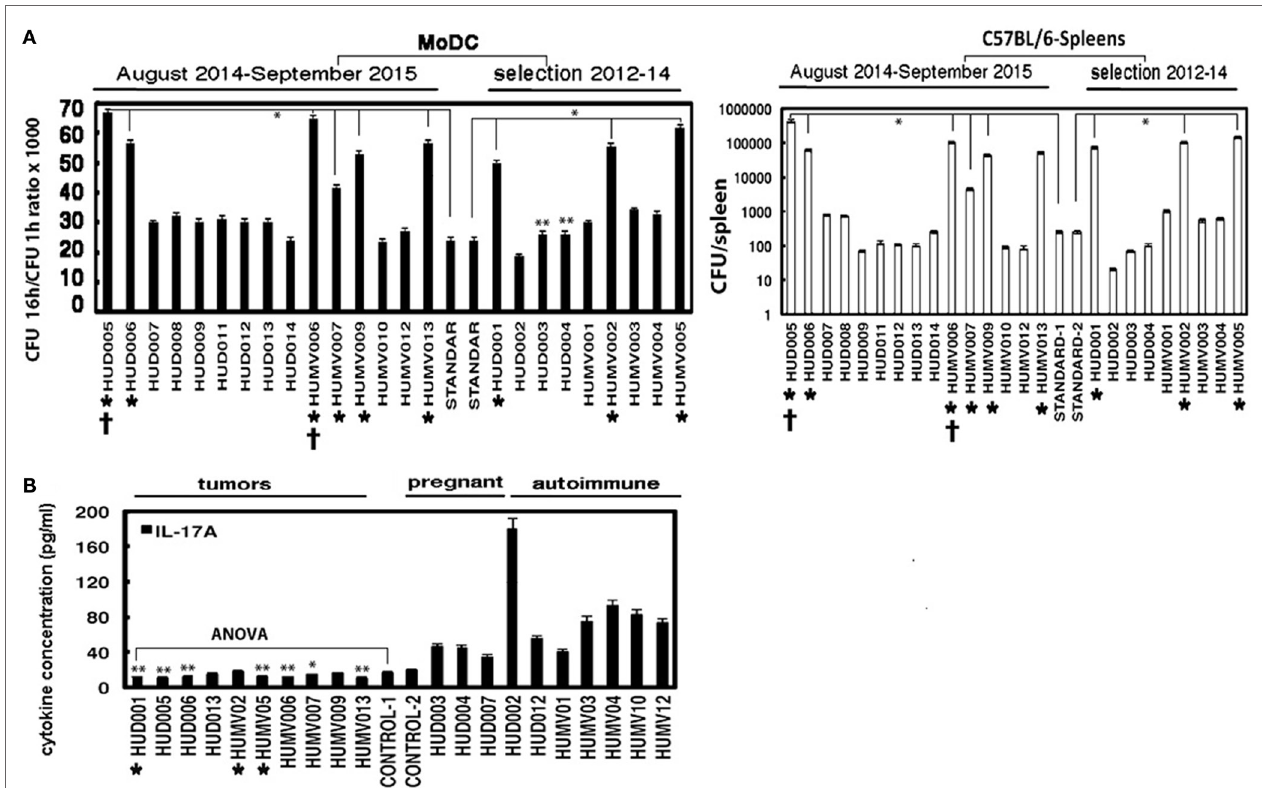
FIGURe 1 | Virulence of clinical isolates of listeriosis patients and immunological biomarkers . (a) Left panel shows the replication index of L. monocytogenes isolates measured as RI in MoDC (black bars). Results are expressed as the mean ± SD of triplicates. * P ≤ 0.05; ** P ≤ 0.01, right panel shows the CFU recovered in the spleens of mice. Results are expressed as the mean ± SD of triplicates. * P ≤ 0.05. Asterisks under the bars indicate 1000-fold higher replication indexes than standard Listeria strains. Standard-1 corresponds to 10403S strain and standard-2 to EGD strain. † Symbols under the bars correspond to deceased patients. (B) IL-7A levels (pg/ml) in sera of all patients with listeriosis (2014–2015 and 2012–2014) clustered by three main clinical manifestations (tumors, pregnancy, and autoimmune disease) measured via flow cytometry (Methods in Supplementary Material). * P ≤ 0.05; ** P ≤ 0.01. Controls are healthy donors. Results are expressed as the mean ±